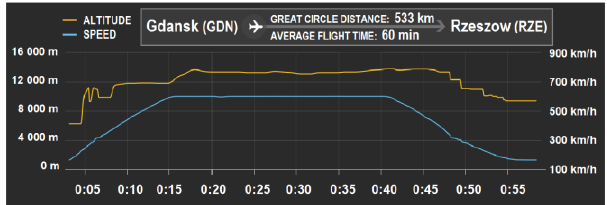
Fig. 1. Trajectory of Gulfstream IV, equipped with two Rolls Royce Tay 611C engines (based on [5])